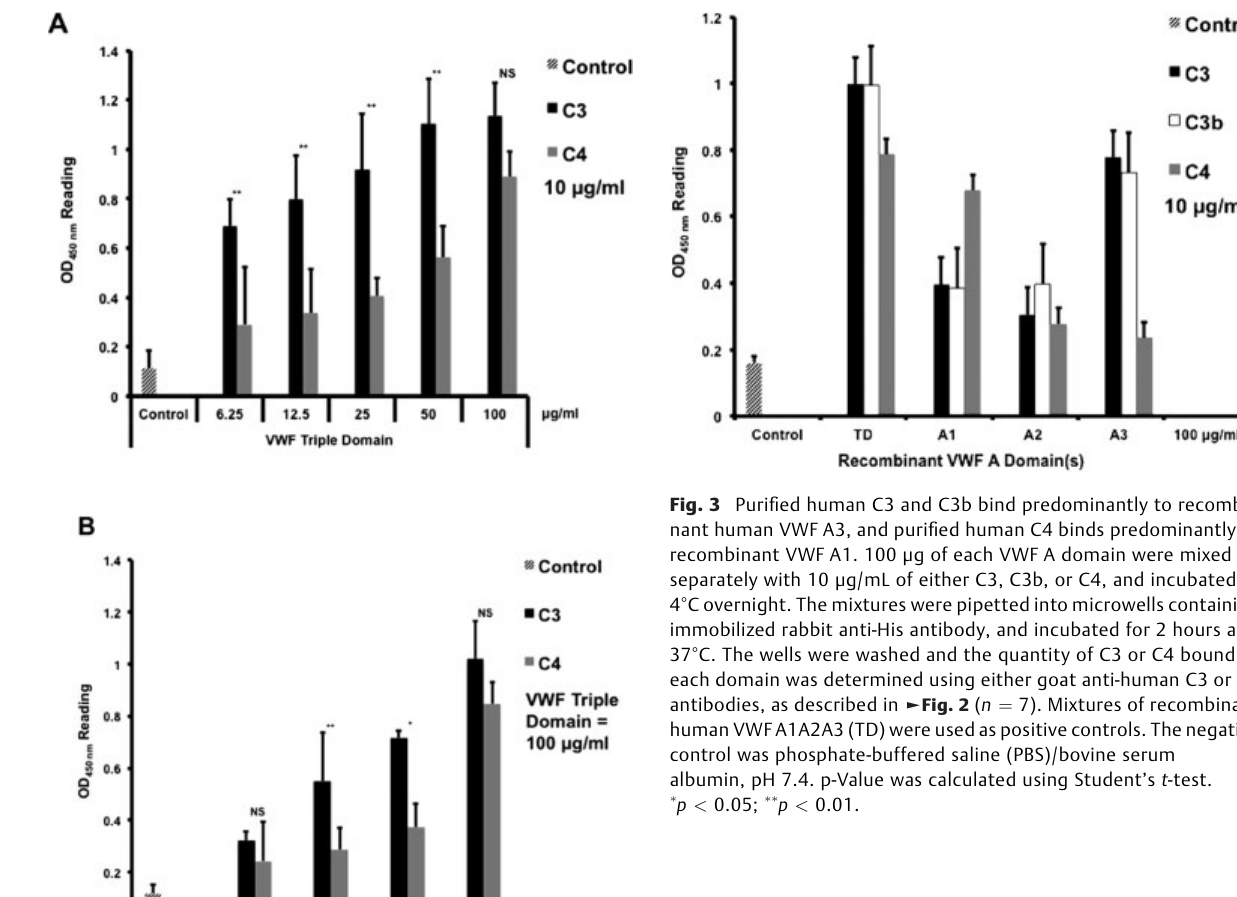
Table 1 Surface plasmon resonance binding Immobilized